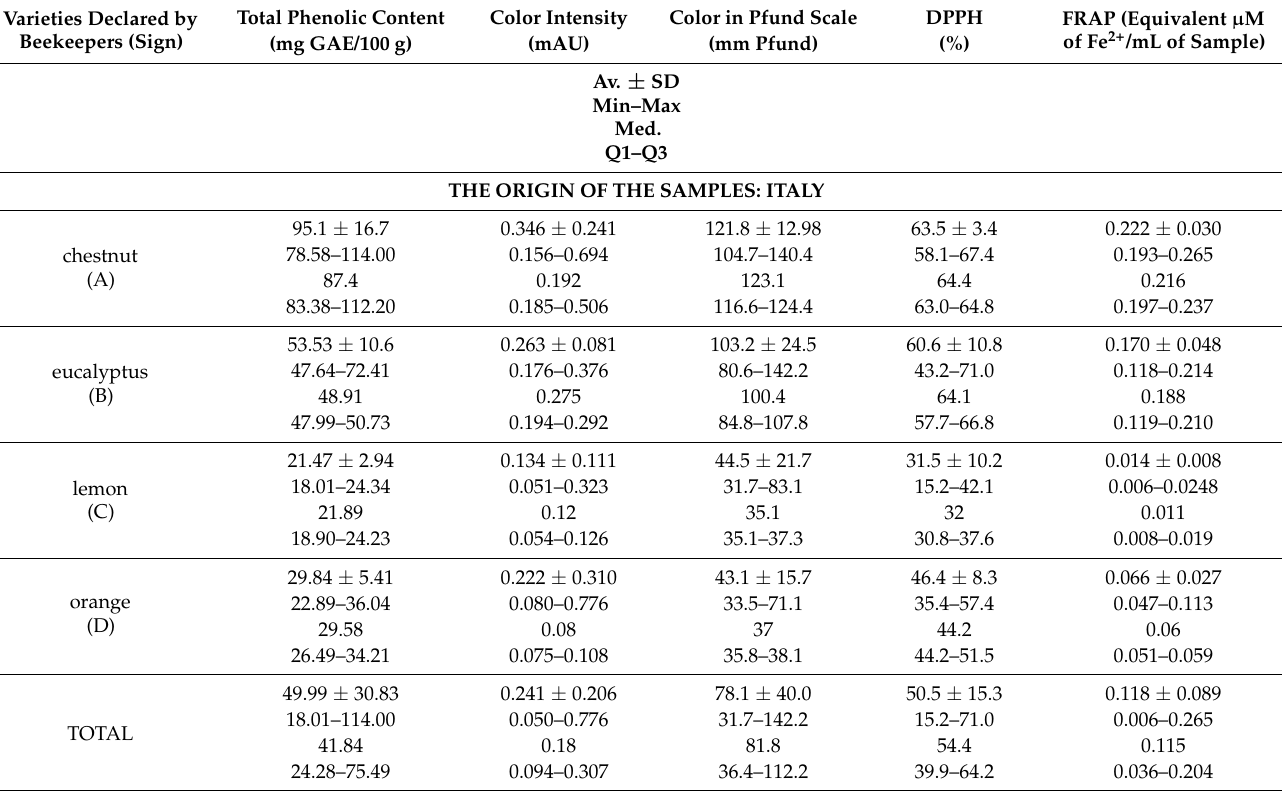
Table 3. The results of research on antioxidant properties—division into varieties according to the manufacturers’